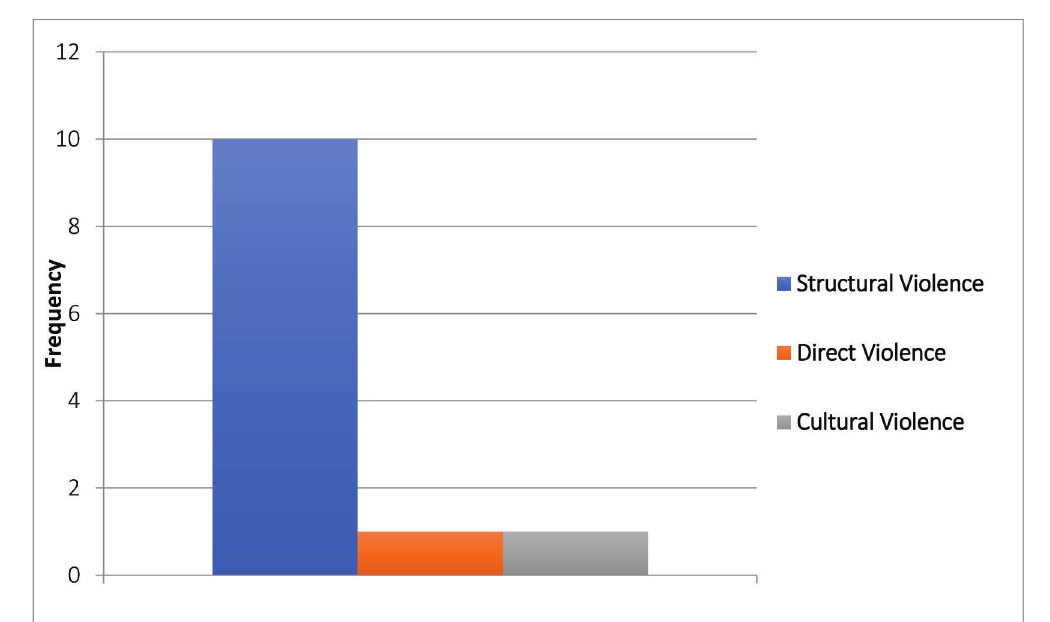
Figure 2: Element One – Recognition of violence in Plan de Estudios